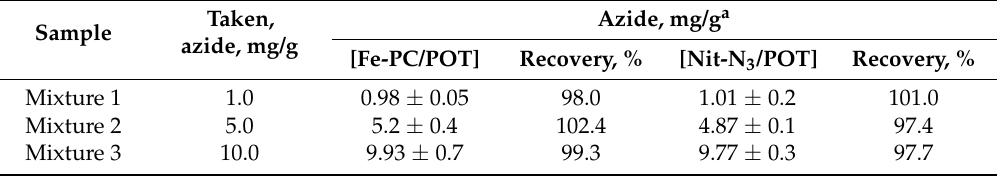
Table 4. Determination of azide in synthetic primer mixtures using the proposed azide